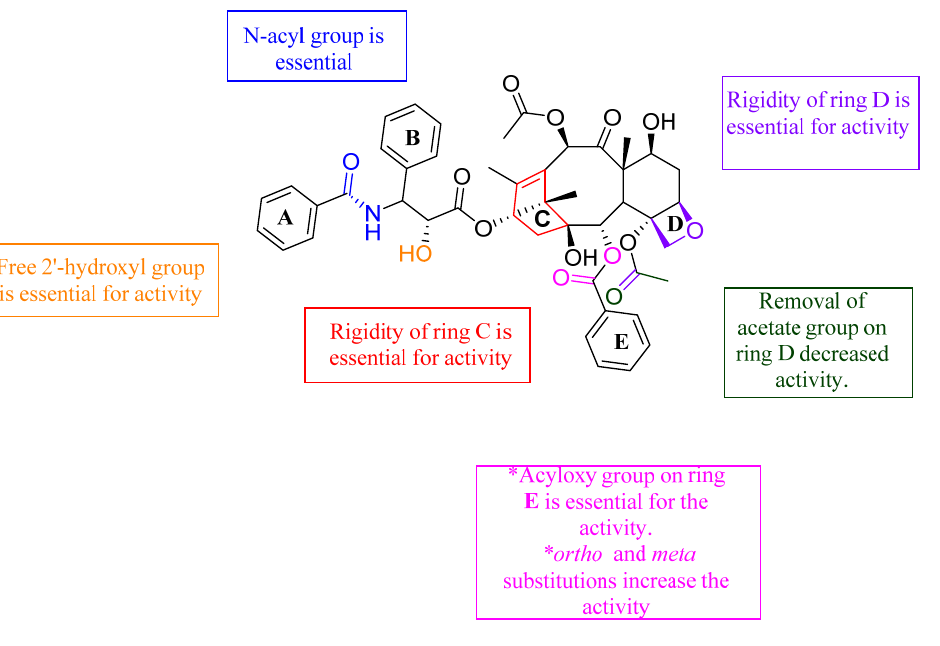
Figure 10. Structure – activity study of paclitaxel analogues [85,86]. The interaction of paclitaxel with microtubule active site (Figure 11) further illumi- nated this SAR, where paclitaxel showed a very high binding affinity with the active site (docking score of − 9.48) [87]. Furthermore, paclitaxel formed three hydrogen bonds and one π – π interaction within the active site, showing a remarkable ability to interact with the microtubule active site.